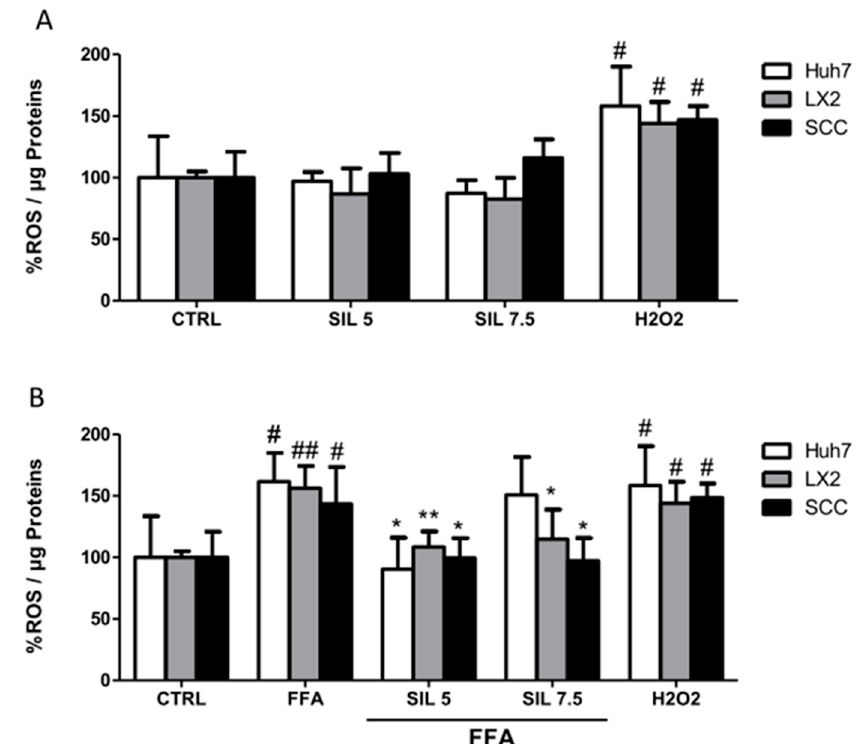
Figure 4. ROS generation. Intracellular ROS was quantified for each condition after 1 h of exposure with Silybin alone ( A ) or in combination with FFA ( B ). Activity was normalized to the total proteins in the cell lysate and reported as a percentage vs. CTRL sample. H2O2 treatment was used as a positive CTRL. # p < 0.05, ## p < 0.01 vs. CTRL; * p < 0.05, ** p < 0.01 vs. FFA.